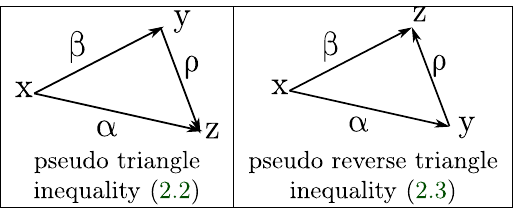
Figure 1: Representation of triangle